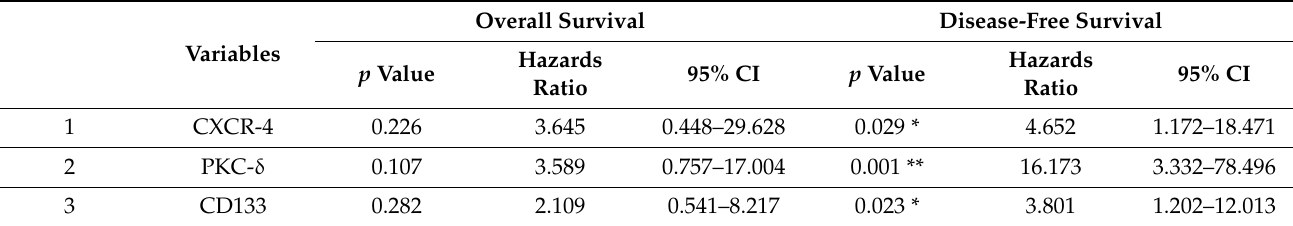
Table 6. Cox multivariate proportional hazards regression